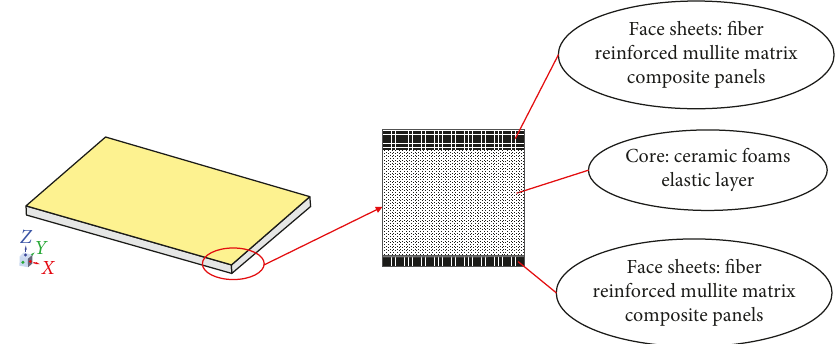
Figure 8: Delamination of the composite layer.